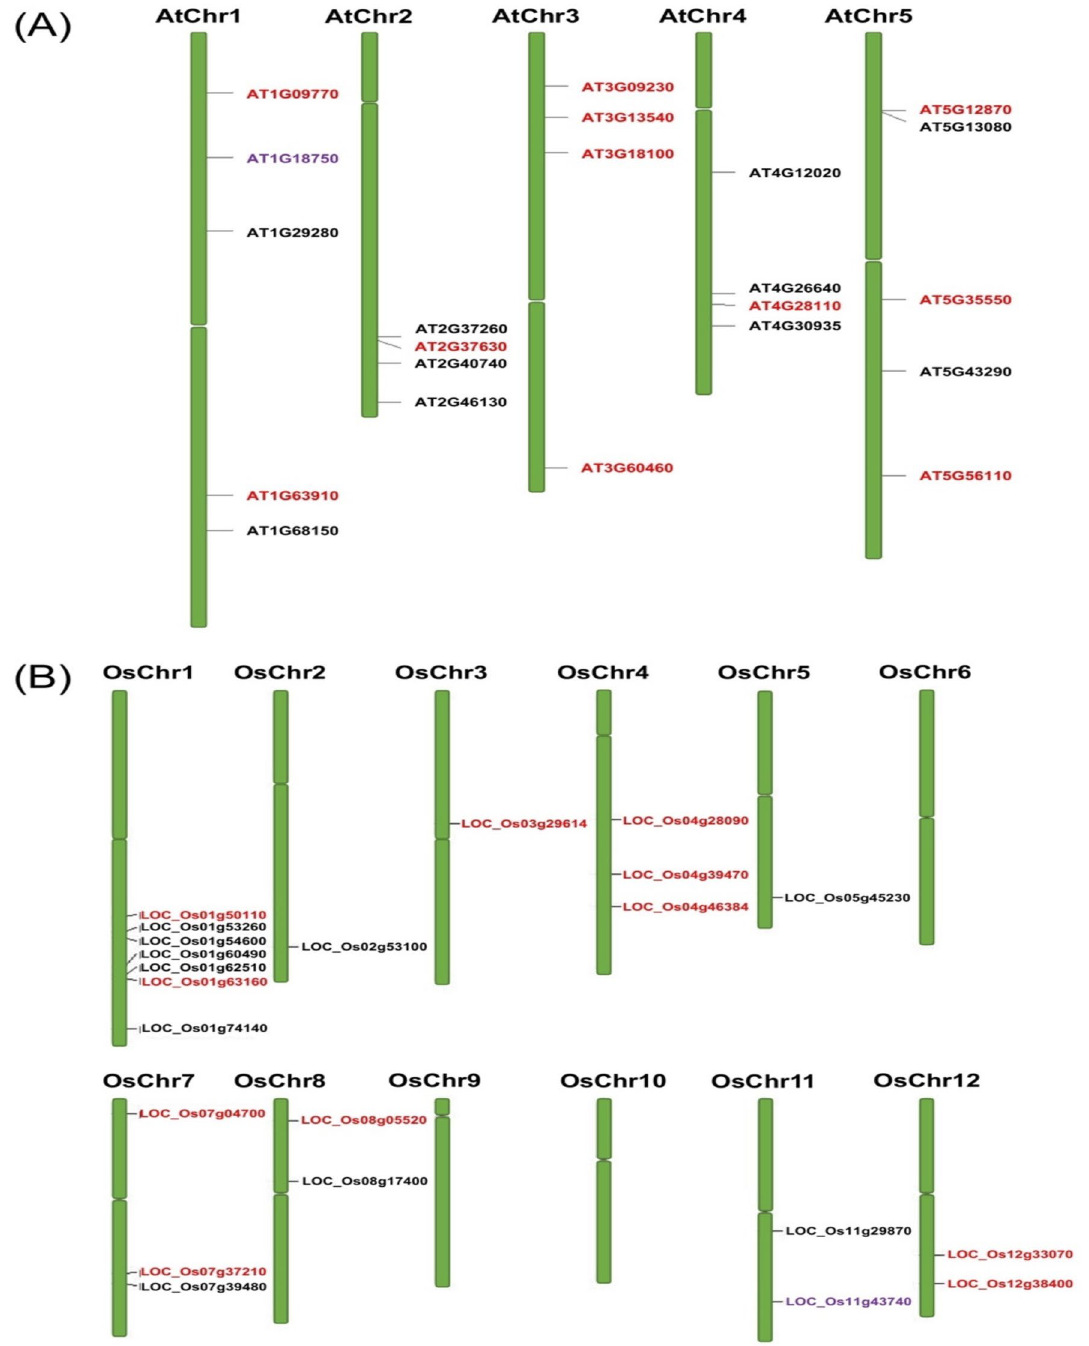
Figure 4. The chromosomal distribution of rice-Arabidopsis WRKY, MADS-box and MYB orthologous gene. ( A ) Distribution of gene loci on Arabidopsis chromosomes. ( B ) Distribution of gene loci on rice chromosomes. Different gene loci colours (naming) represents a gene transcription factor family: WRKY; black, MADS-box; purple and MYB;